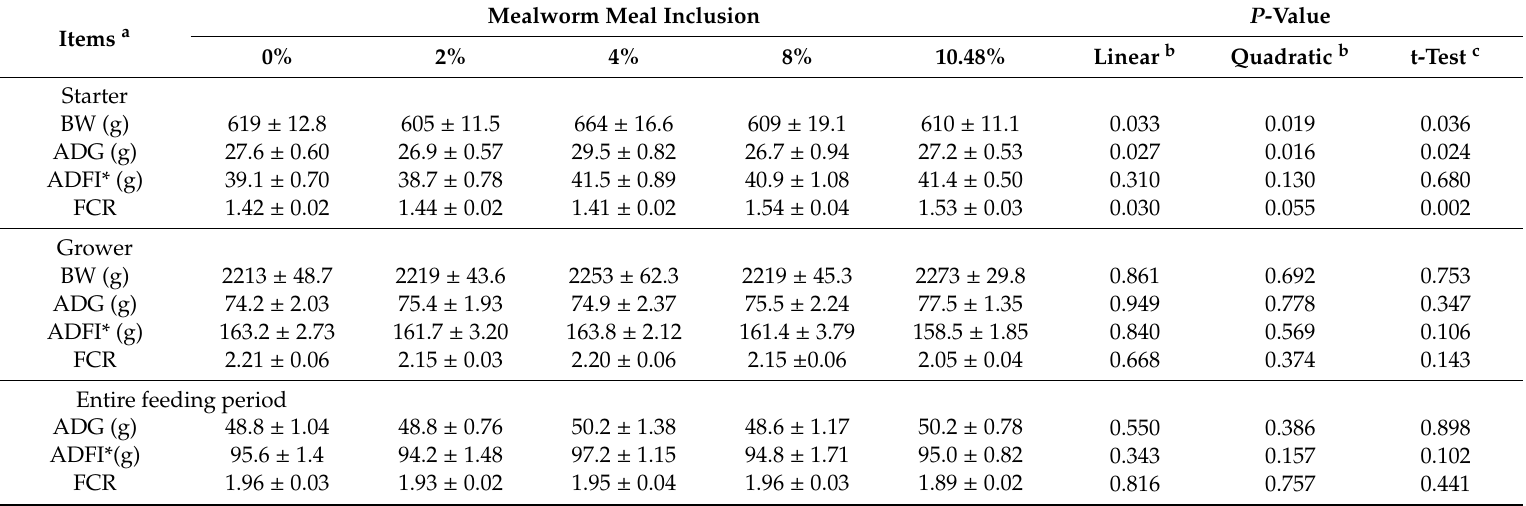
Table 3. Growth performance of the broiler chicks fed on the MWM